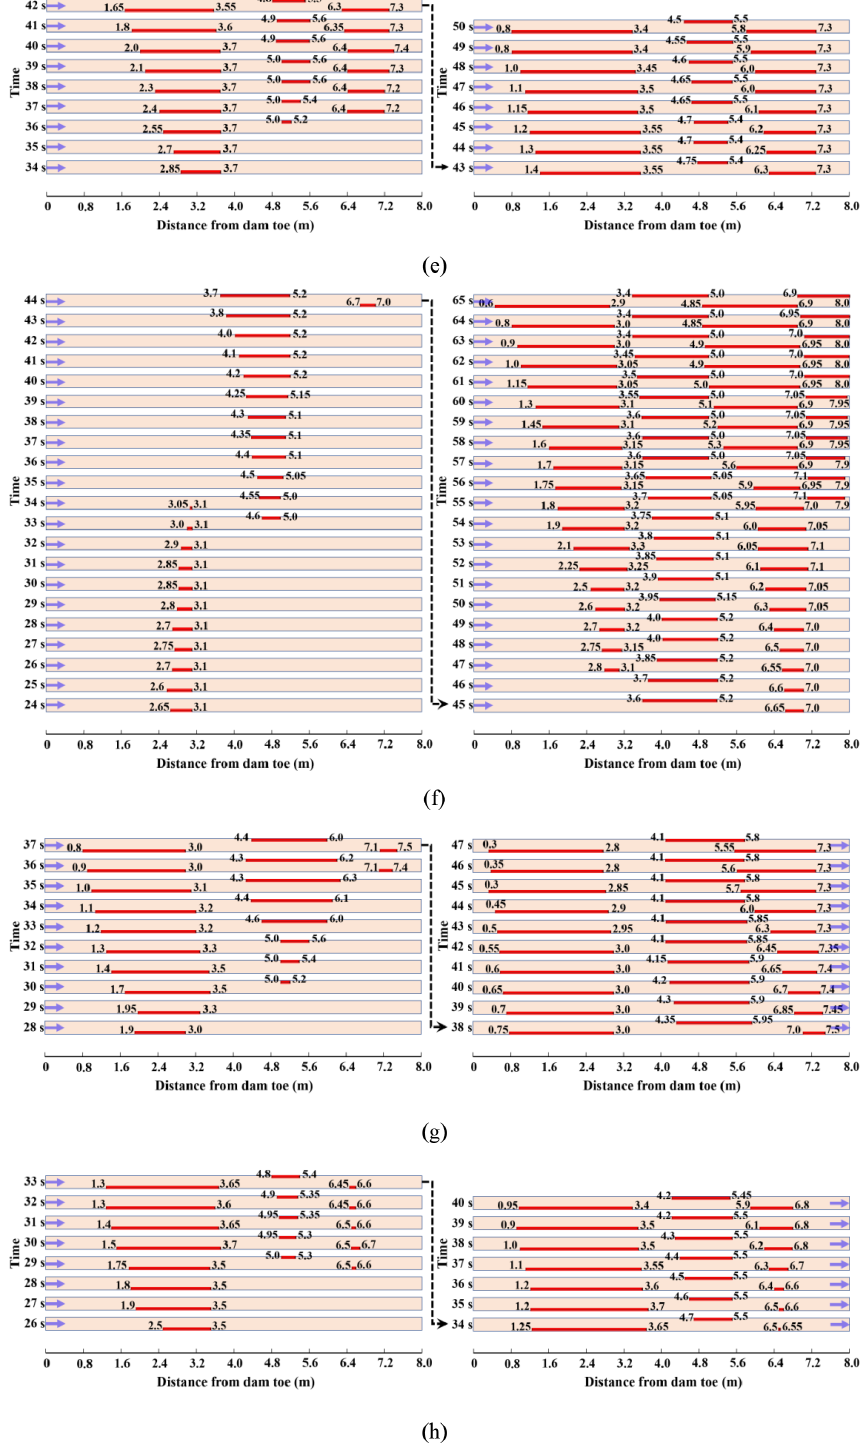
Figure 5. The boulder bars’ locations during the dam failure process. Notation: (a–h) represent the boulder bars’ locations for T1–T8 tests, respectively. The red lines in the figure represent the boulder bars, and the orange rectangles represent the channels. Moreover, the purple arrow represents the direction of flow. The numbers at both ends of the red lines represent the distances between the upstream and downstream edges of boulder bars and the dam